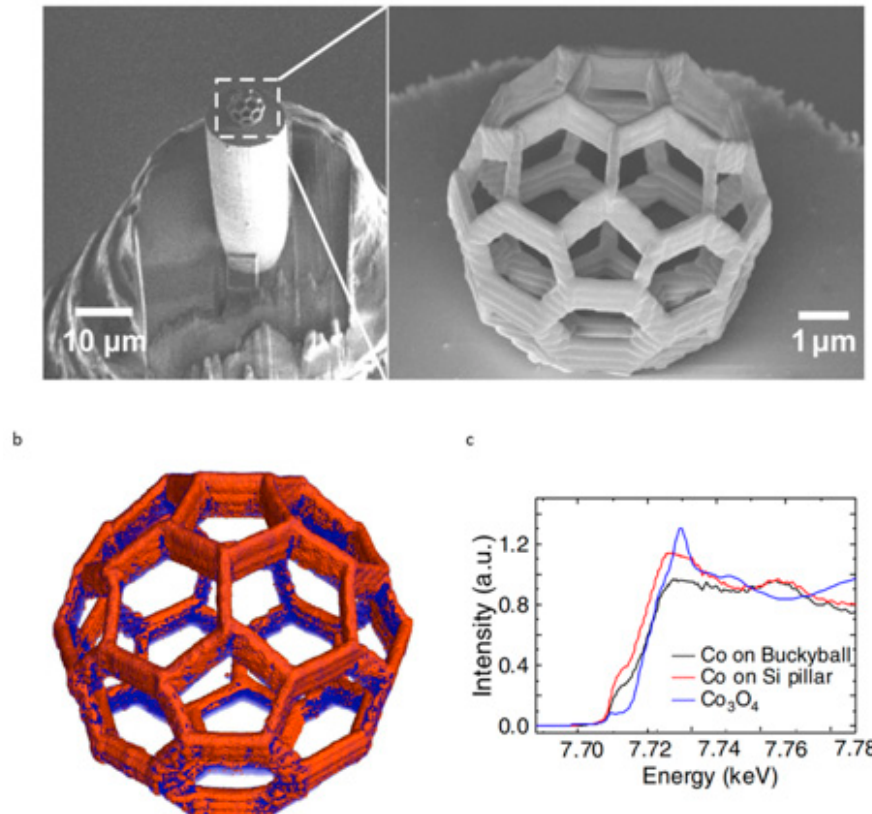
Figure 6. Physical characterisation of a cobalt-coated buckyball. ( a ) SEM images displaying the buckyball mounted upon a tomography pin (left) and a magnified image of the fabricated structure (right); ( b ) 3D rendering of the buckyball composition, obtained by x-ray tomography, cobalt is indicated by orange contrast whilst photoresist is blue; ( c ) Fluorescence spectra of cobalt deposited upon the polymer sca ff old, upon the pillar and cobalt oxide detected in transmission